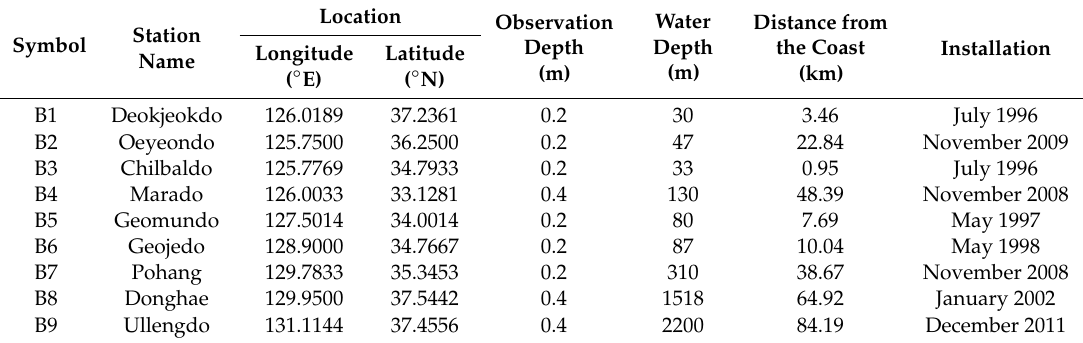
Table 1. In situ observations from the KMA stations from B1 to